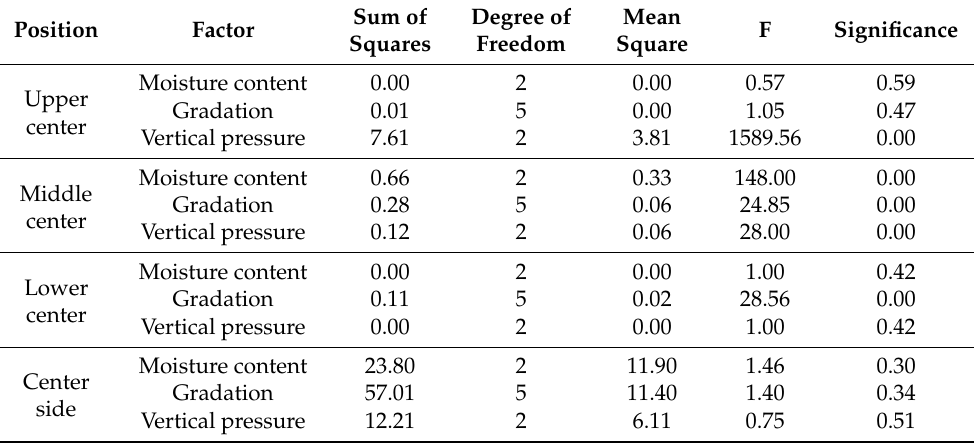
Table 5. The variance statistics of particle accelerations at different positions of gyratory specimens designed by the or- thogonal array method.